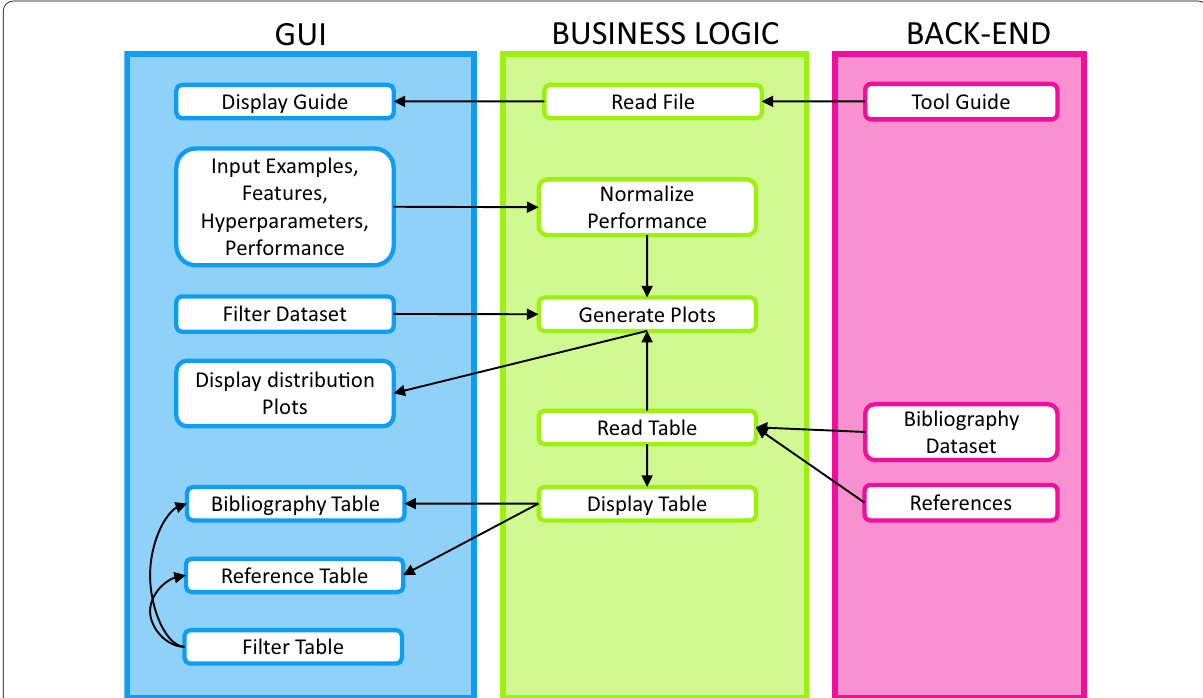
Fig. 3 Functional block diagram of the online tool, where the relationships between elements of the graphical user interface, the business logic and the back-end are